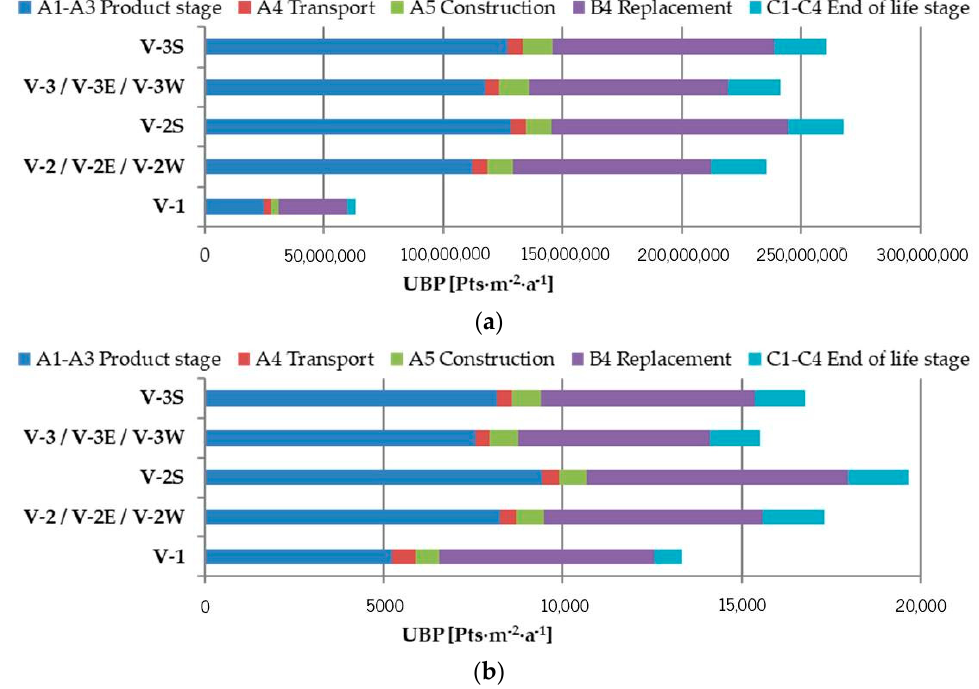
Figure 6. Embodied environmental impacts (EEIs) of the assessed variants of the house per life cycle stages and modules according to EN 15978: ( a ) total results; ( b ) results per 1 m 2 of treated floor area (TFA) and year of operation.